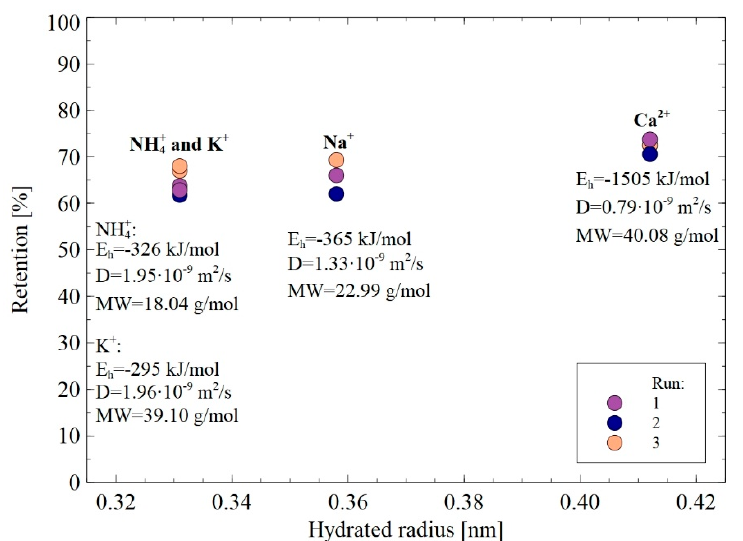
Figure 13. Retention of cations in function of hydrated radius during the NF process. TMP = 1.4 MPa, T = 298 K, J = 30 L/m 2 h.